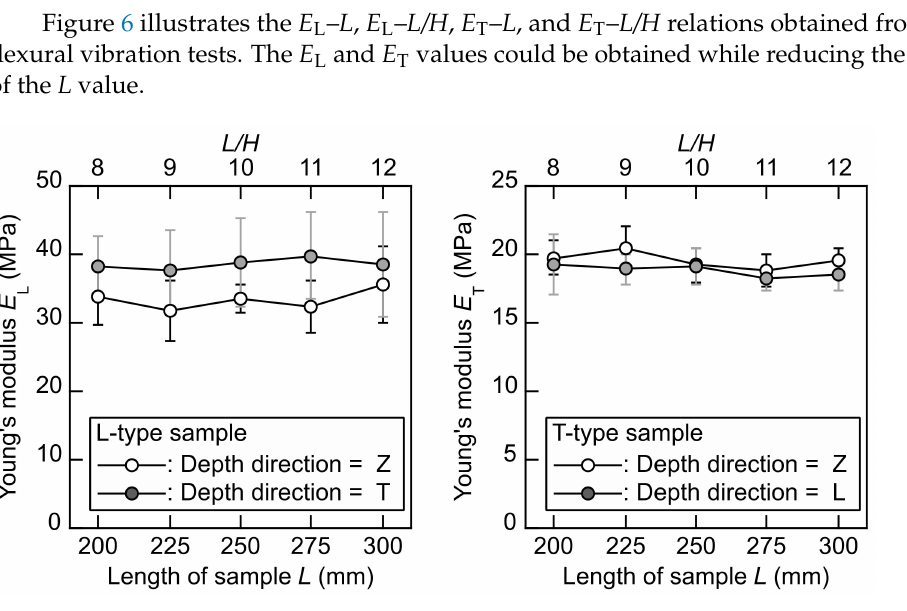
Figure 6. E L – L , E L – L/H , E T – L , and E T – L/H relations determined by flexural vibration tests. Results = average ± standard